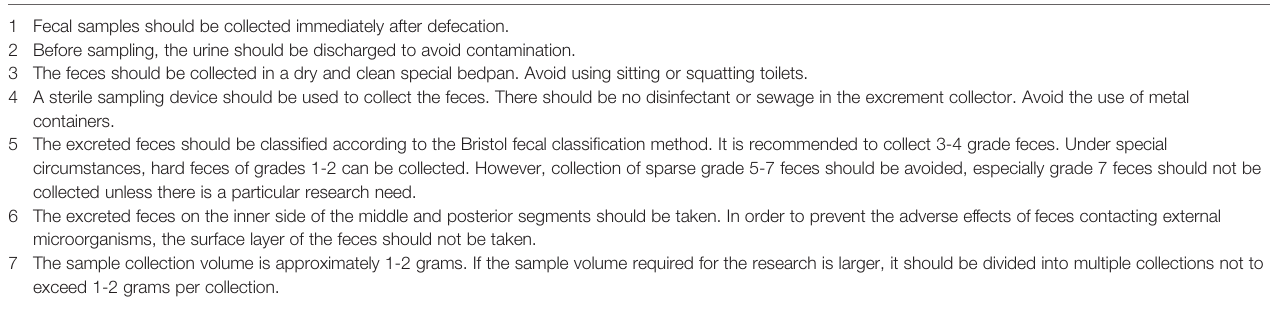
TABLE 1 | Primary points of the collection method of fecal samples in TCM clinical